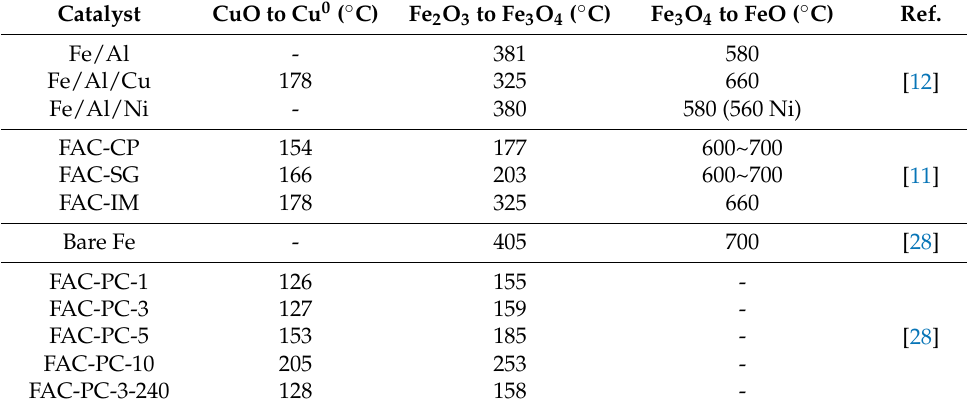
Table 3. Reduction characteristics of Fe-based